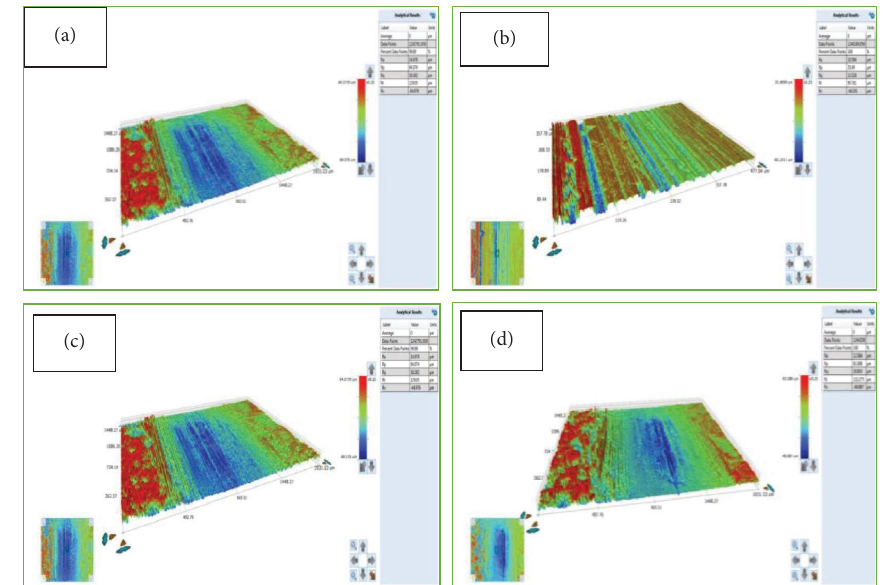
Figure 14: Surface topography of alloy under dry condition at (a) 20N, (b) 30N, (c) 40N, and (d) 50N.